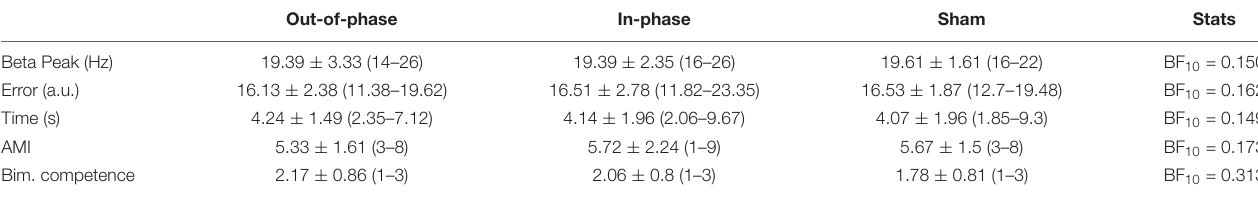
TABLE 1 | No baseline differences between groups for the group allocation parameters (mean ± SD and range).